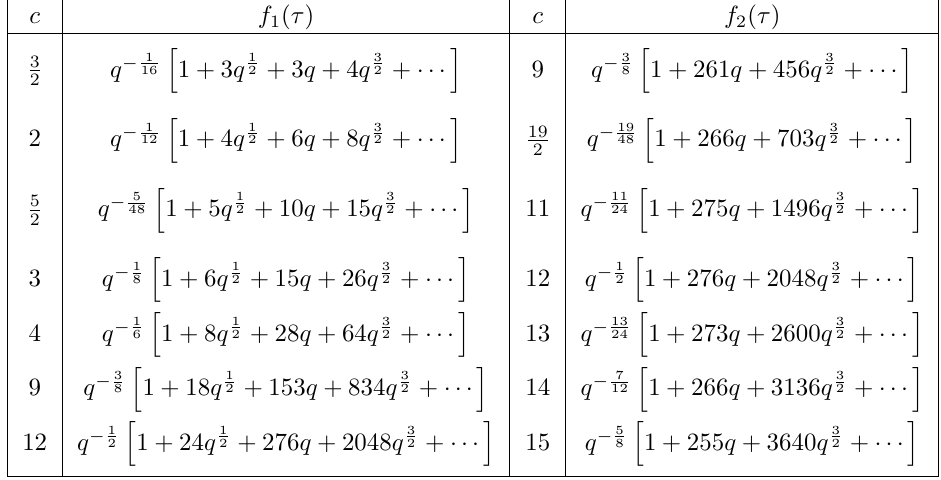
Table 7 . Solutions for the second order modular di(cid:11)erential equation.